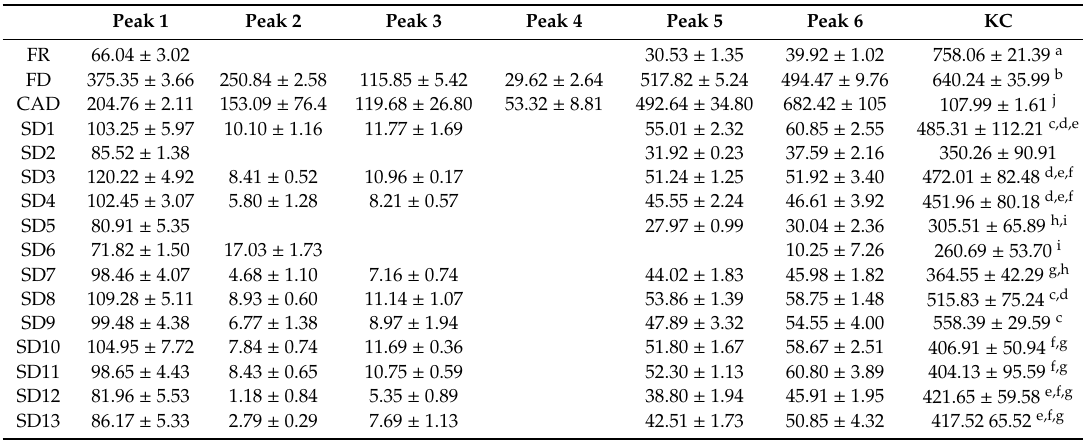
Table 2. Kuromanin concentration (KC) of frozen and dried